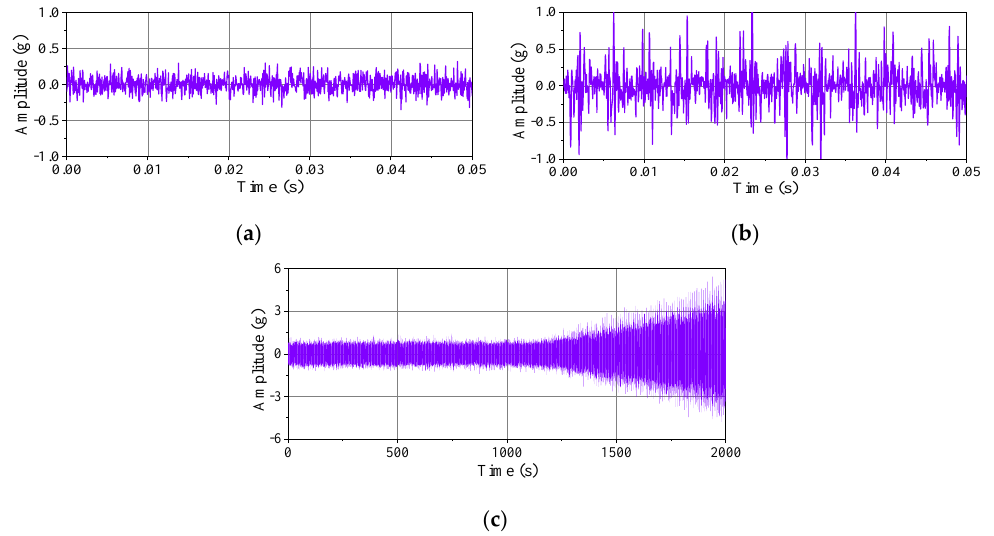
Figure 5. Simulation of the bearing: ( a ) normal stage sample, ( b ) degraded stage sample, and ( c ) vibration signals of the whole lifetime.